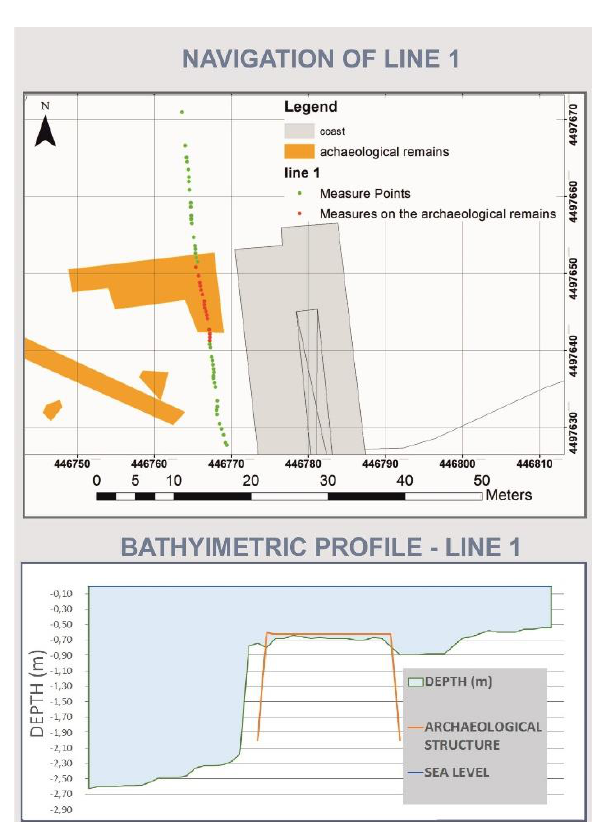
Figure 13. Navigation of Line 1 in the upper part, and bathymetric profile in the lower